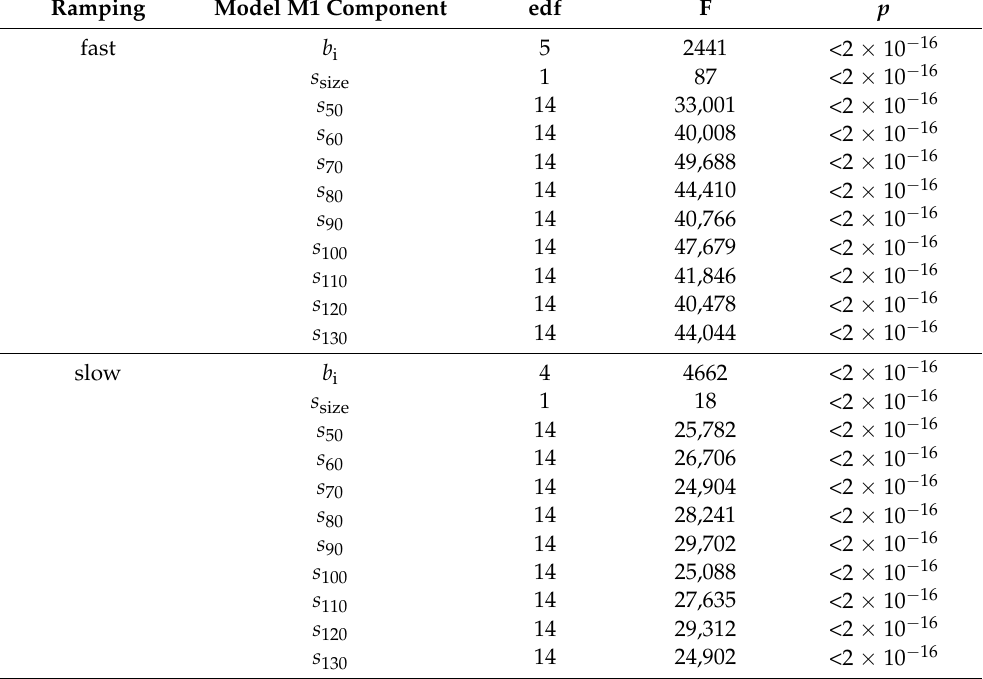
Table 2. Results of the generalized additive mixed model M1 assessing variation in individual model components for fast ramping (n = 1,202,670; deviance explained = 82.3%; restricted maximum likelihood score (REML) = 3.9 × 10 6 ; Akaike information criterion (AIC) = 7,887,672) and for slow ramping (n = 1,058,036; deviance explained = 76.7%; REML = 3.9 × 10 6 ; AIC = 7,769,839). The effective degrees of freedom (edf), F statistic (F) and the probability value of the statistic ( p ) are represented. Ramping Model M1 Component